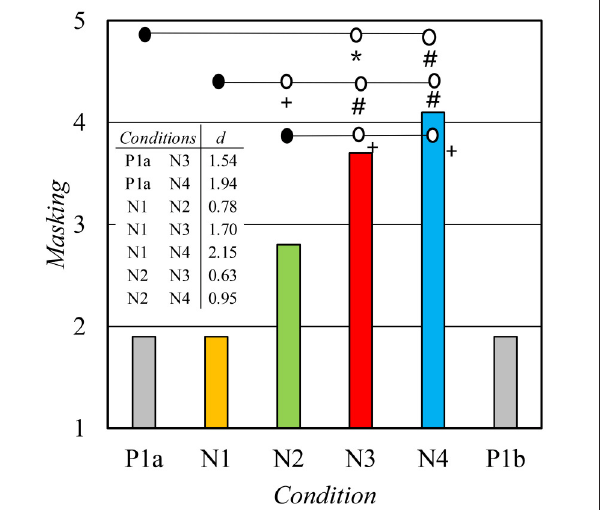
FIGURE 6 | The mean disturbance of work caused by sound masking. Scale: 1 Not at all, 5 Very much. Levels of statistical significance: + p < 0.05, * p < 0.01, # p <